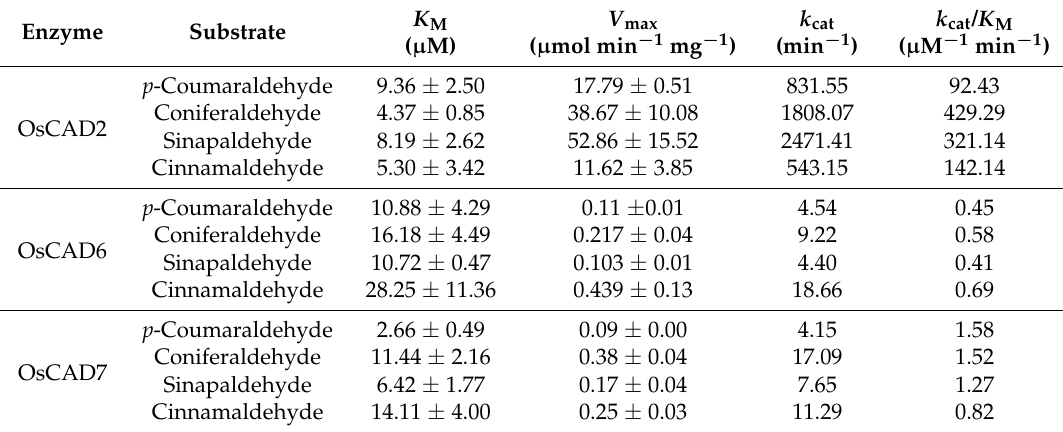
Kinetic parameters of recombinant OsCAD2, 6 and 7 catalyzed reactions toward hydroxycinnamaldehydes a